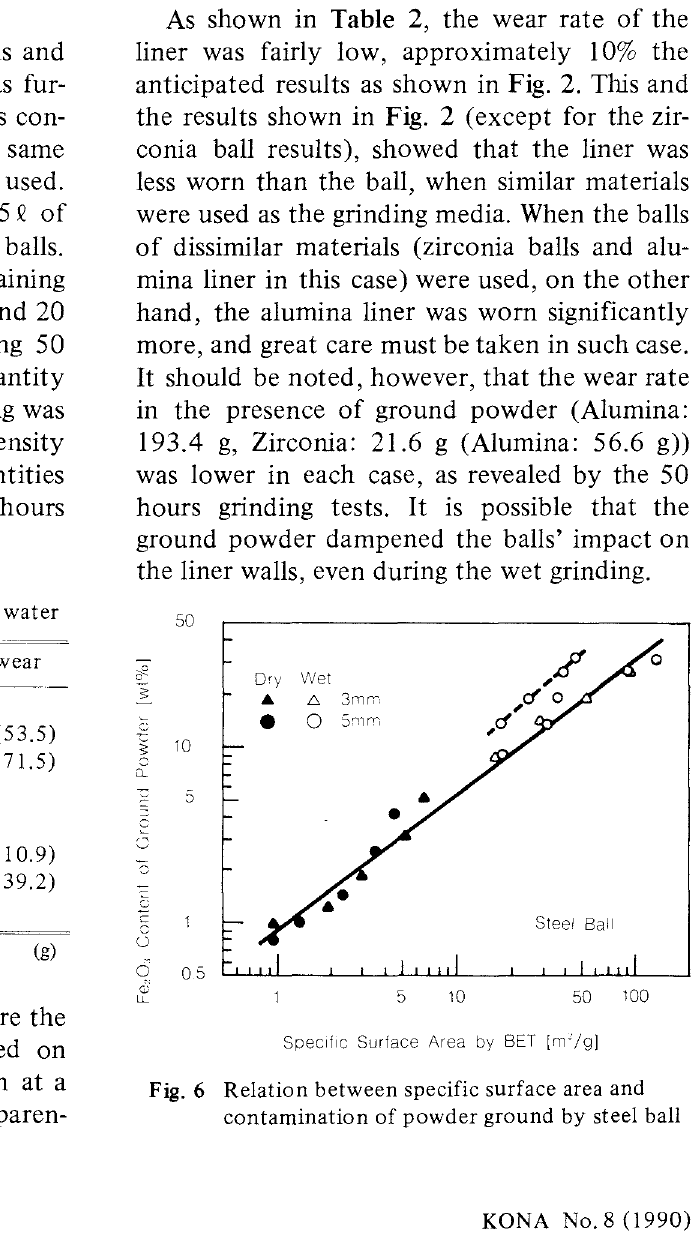
Fig. 6 Relation between specific surface area and contamination of powder ground by steel